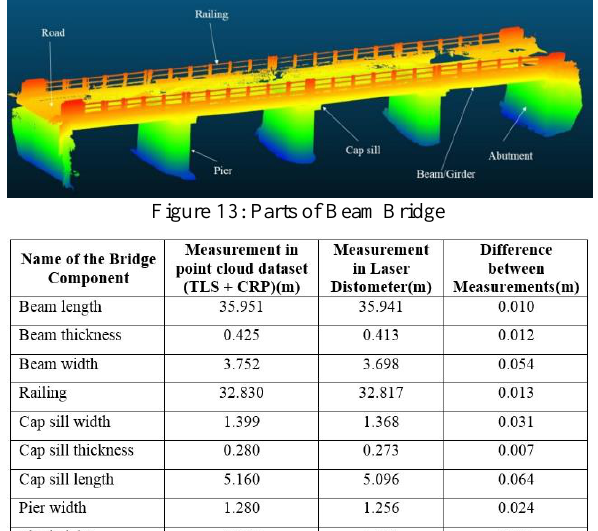
Table 4: comparison of measurements of Beam Bridge